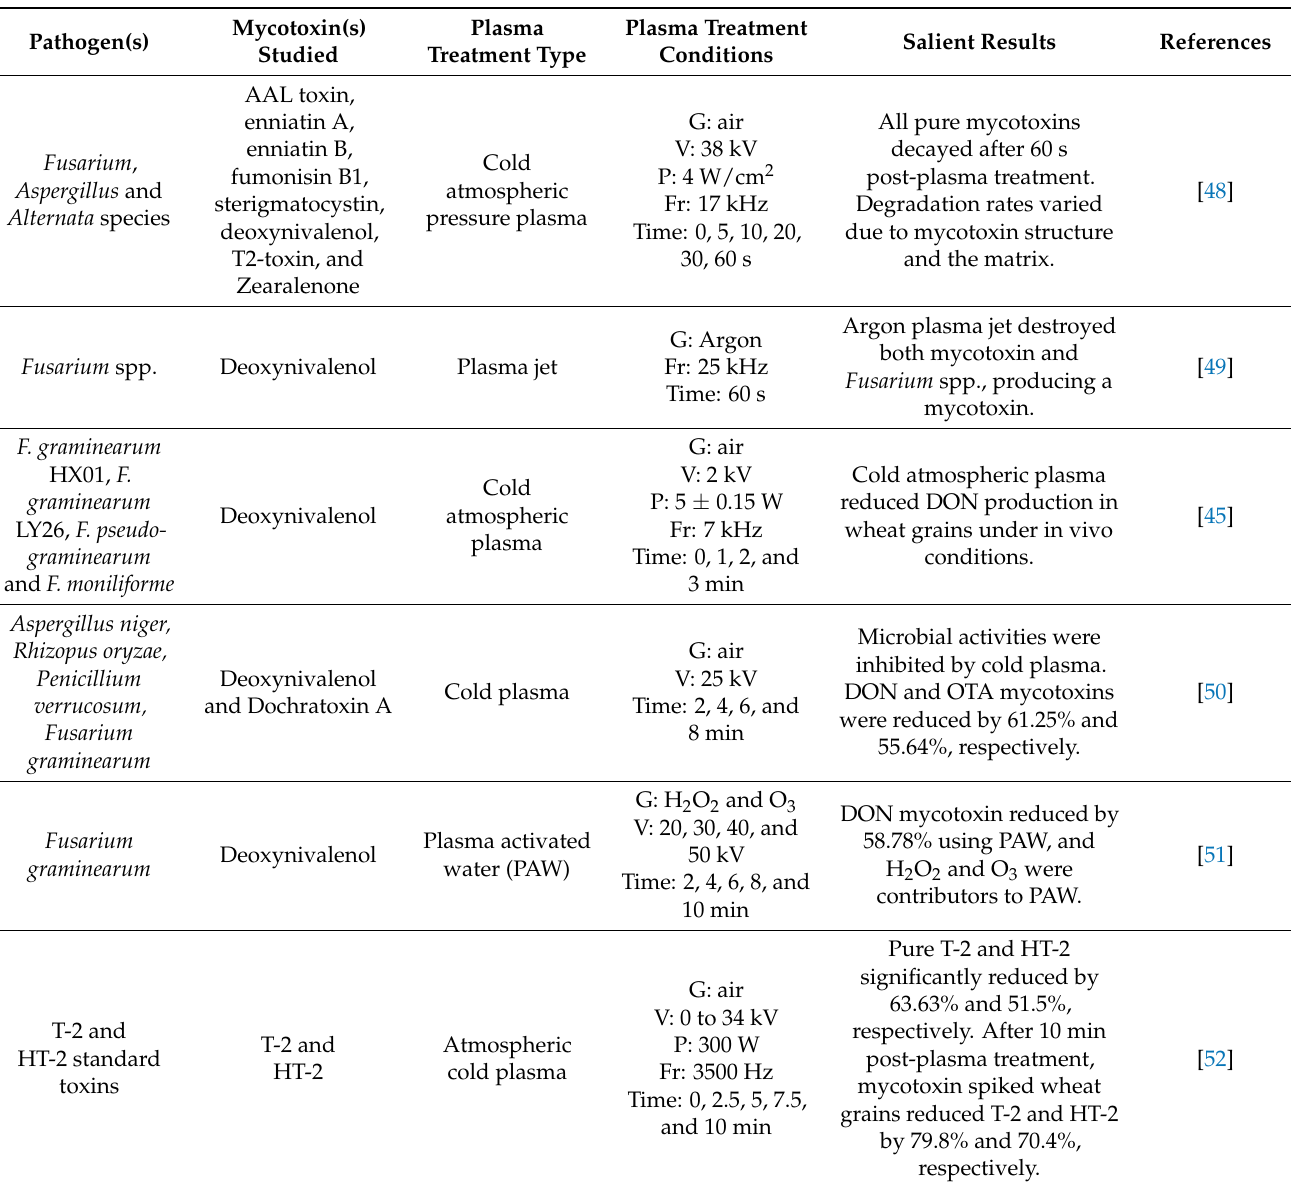
Table 2. List of the conducted research on “non-thermal plasma”/“cold plasma” in degrada- tion/decontamination of Deoxynivalenol (DON) mycotoxin produced by Fusarium